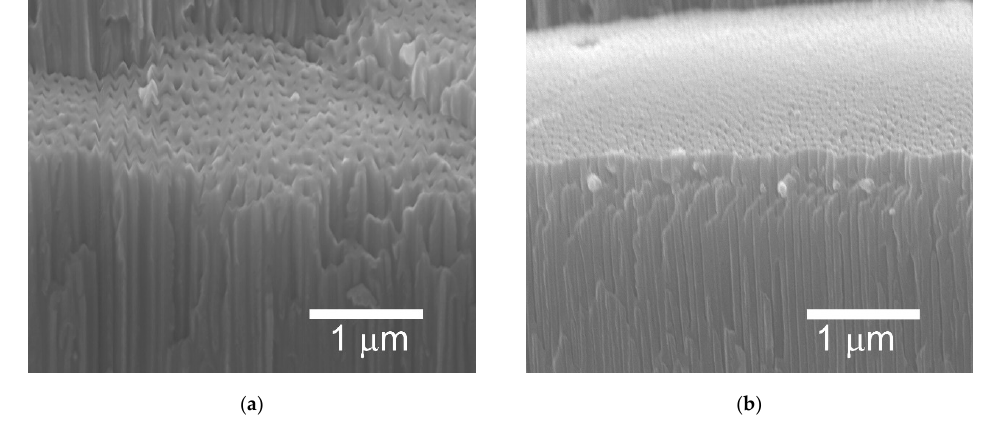
Figure 4. SEM micrographs of a fresh cross section of an oxide coating ( a ) Al 2 O 3 and ( b ) Al 2 O 3 /IF-WS 2 .